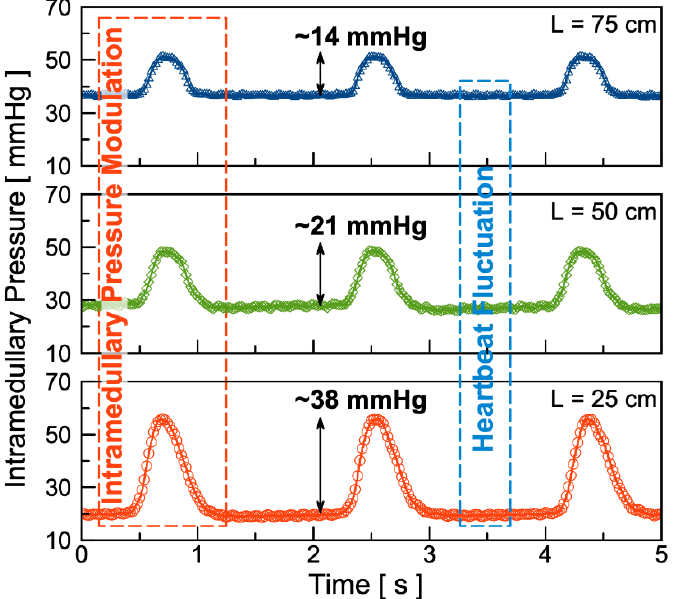
Figure 6. Test results of in vivo intramedullary fluid modulation on a six-month-old Fischer-344 rat using PE90 tubes 75 cm (top), 50 cm (middle), and 25 cm (bottom) in length. The external magnet used is a NdFeB magnet with a diameter of 38.1 mm and 12.7 mm thick, operated at distance ranging from 18 mm to 88 mm.